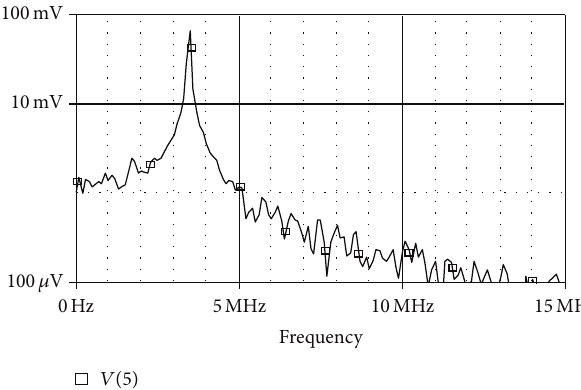
Figure 6: Output signal spectrum at pole